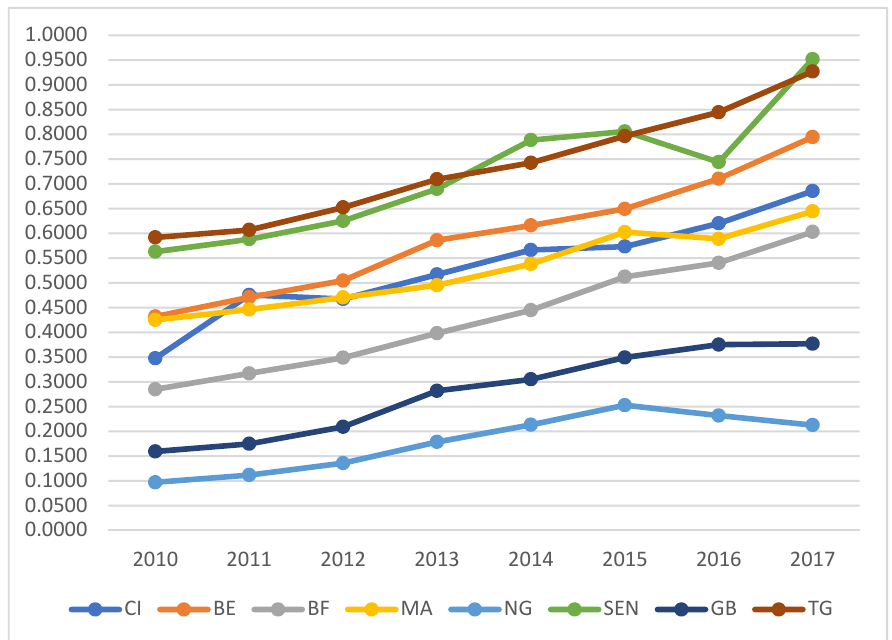
Figure 5. AS–CEA from 2010 to 2017.